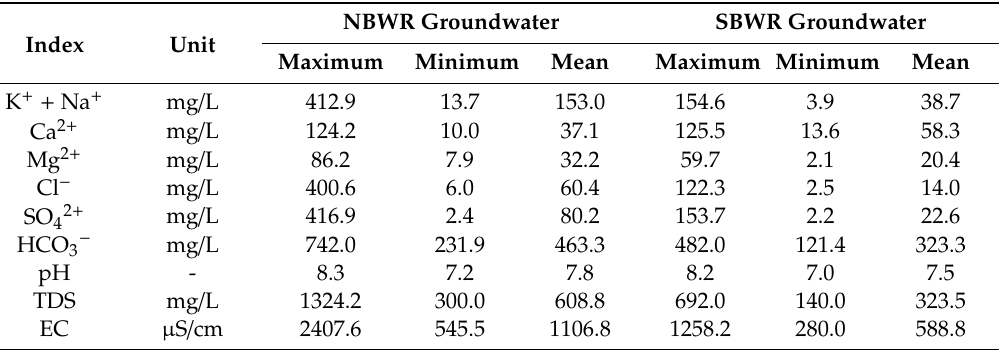
Table 1. Physicochemical groundwater